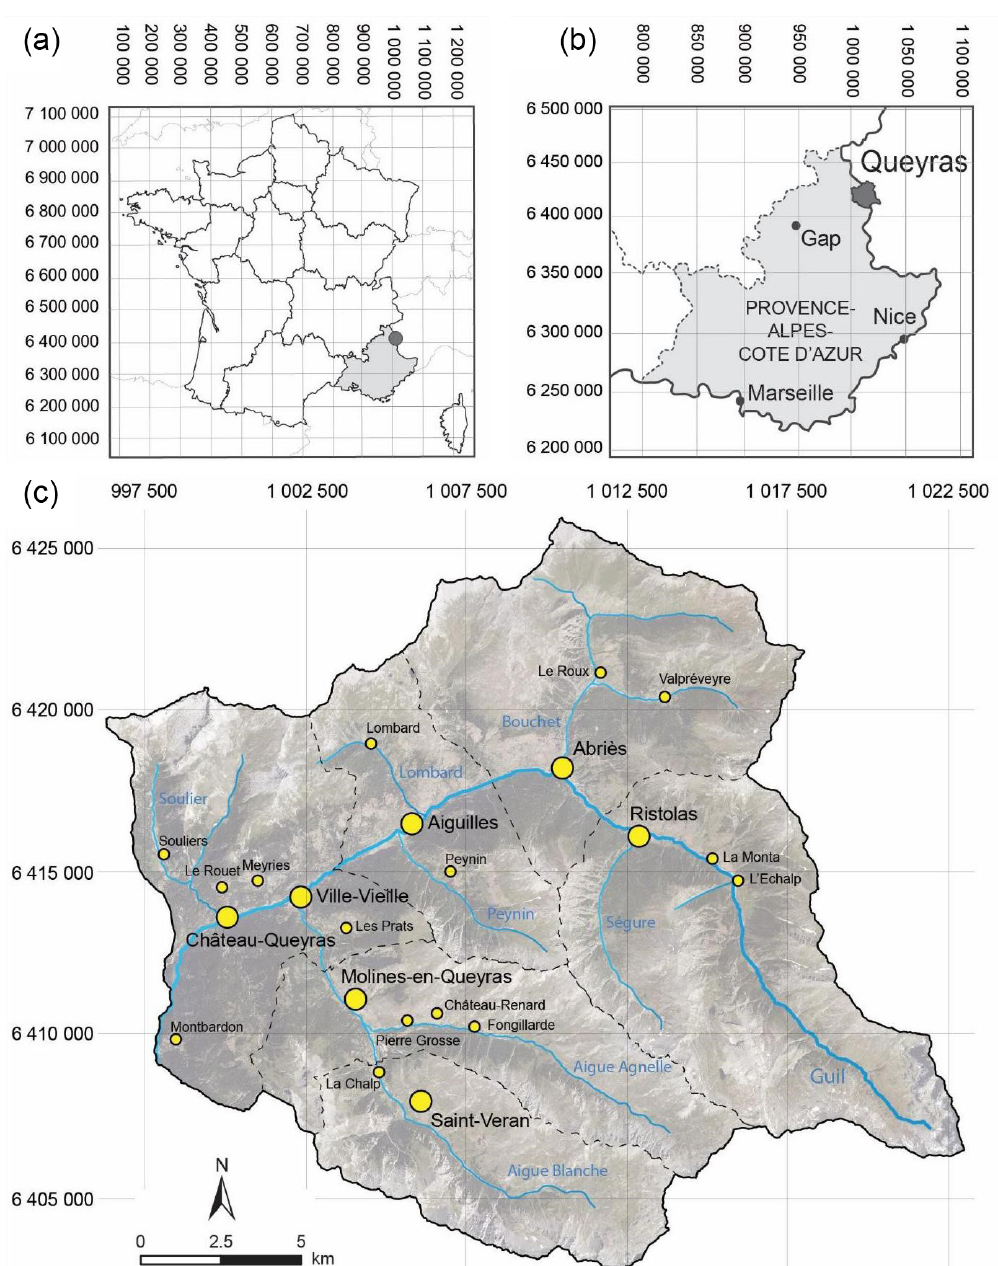
Figure 1. Location map of the Upper Guil catchment and its six